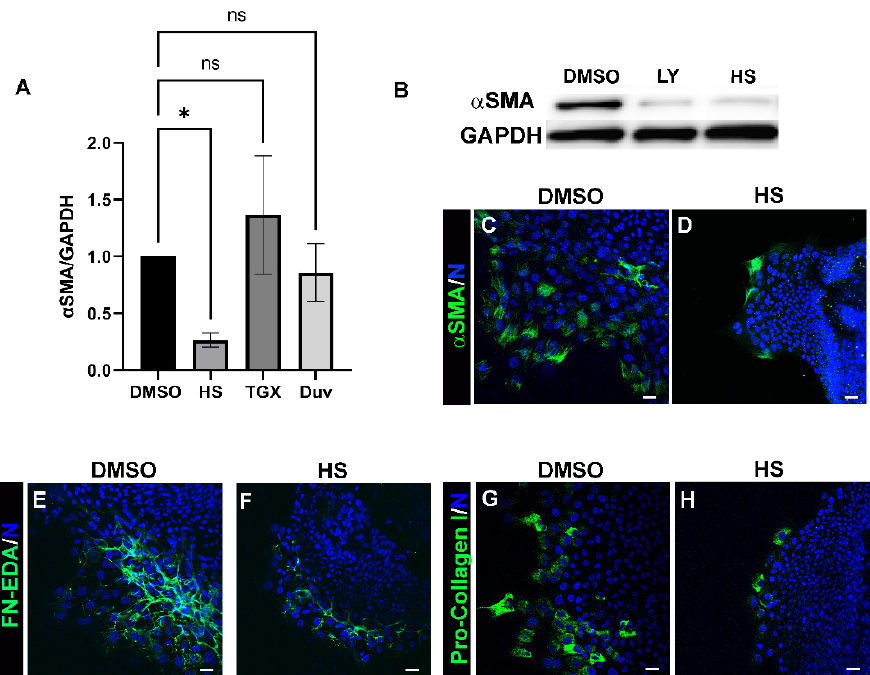
Figure 2. The fibrotic response of mesenchymal leader cells is signaled through PI3K 110 α post- cataract surgery wounding. ( A ) Ex vivo post-cataract surgery explants were treated with vehicle or PI3K isoform specific inhibitors: HS-173 (HS), a PI3K p110 α specific inhibitor; TGX-221 (TGX), a PI3K p110 β -specific inhibitor; or Duvelisib (Duv) a PI3K δ / γ selective inhibitor through day 3. Lysates were subjected to immunoblot analysis to determine the effect on α SMA expression.